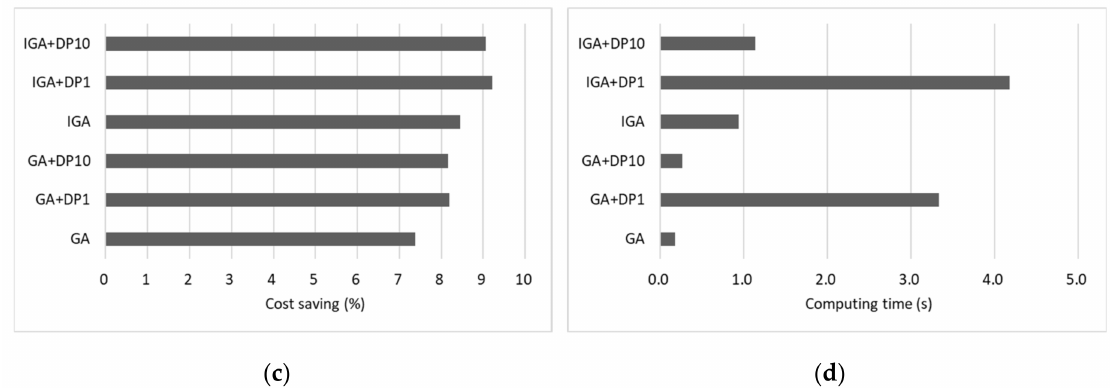
Figure 7. Comparison between the combined methods with GA and those with improved genetic algorithm (IGA). ( a ) Average cost saving over all cases without demand charge; ( b ) average computing time over all cases without demand charge; ( c ) average cost saving over all cases with demand charge; ( d ) average computing time over all cases with demand